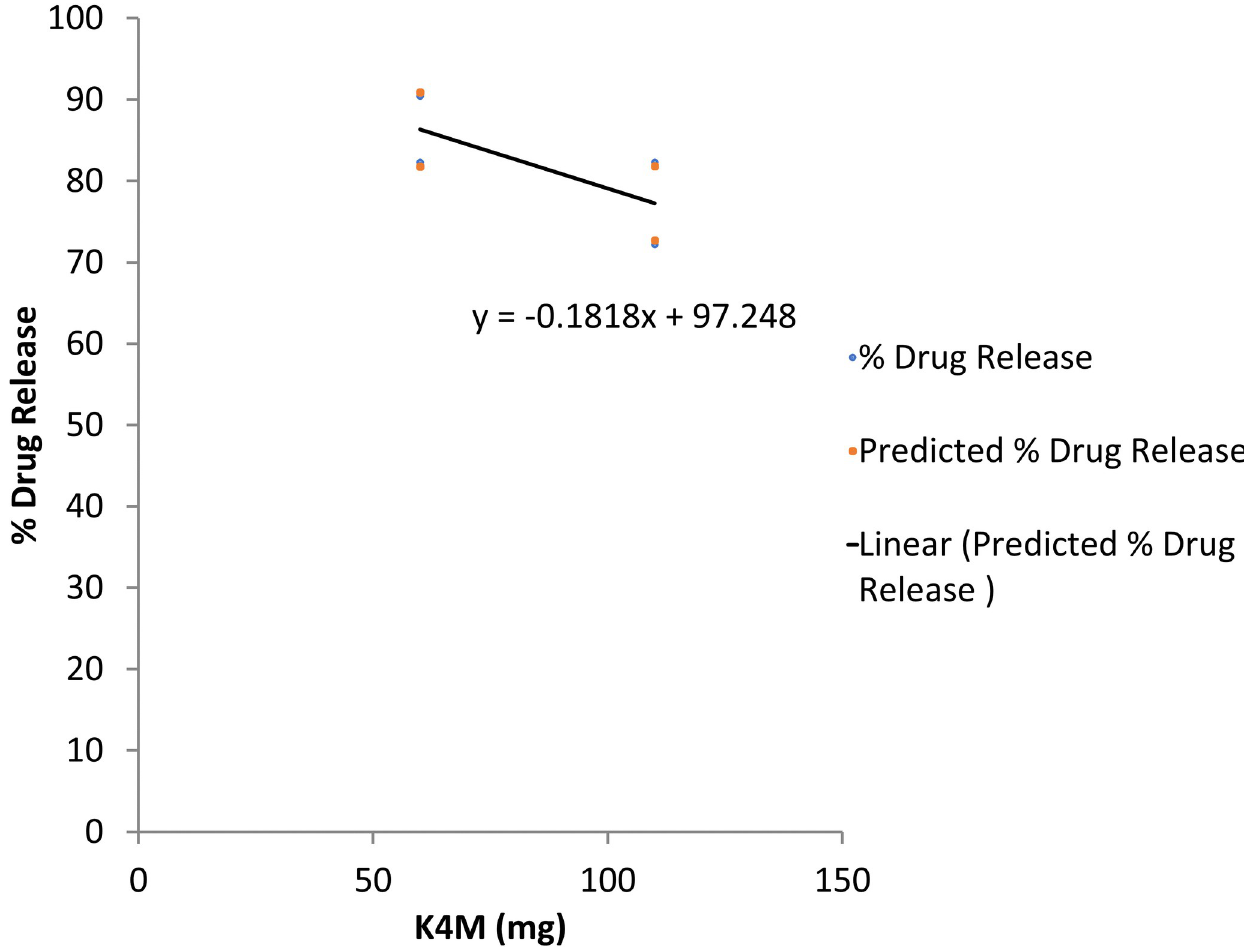
Fig 9. Line fit plot for the response of percent drug dissolution with HPMC